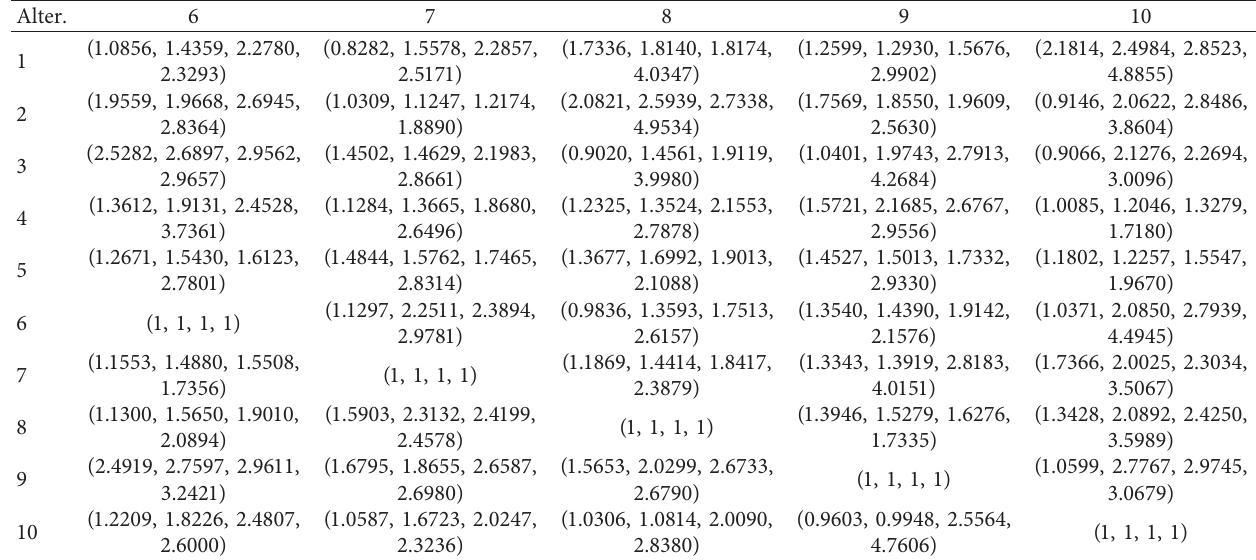
(part 2: columns 6–10). URL